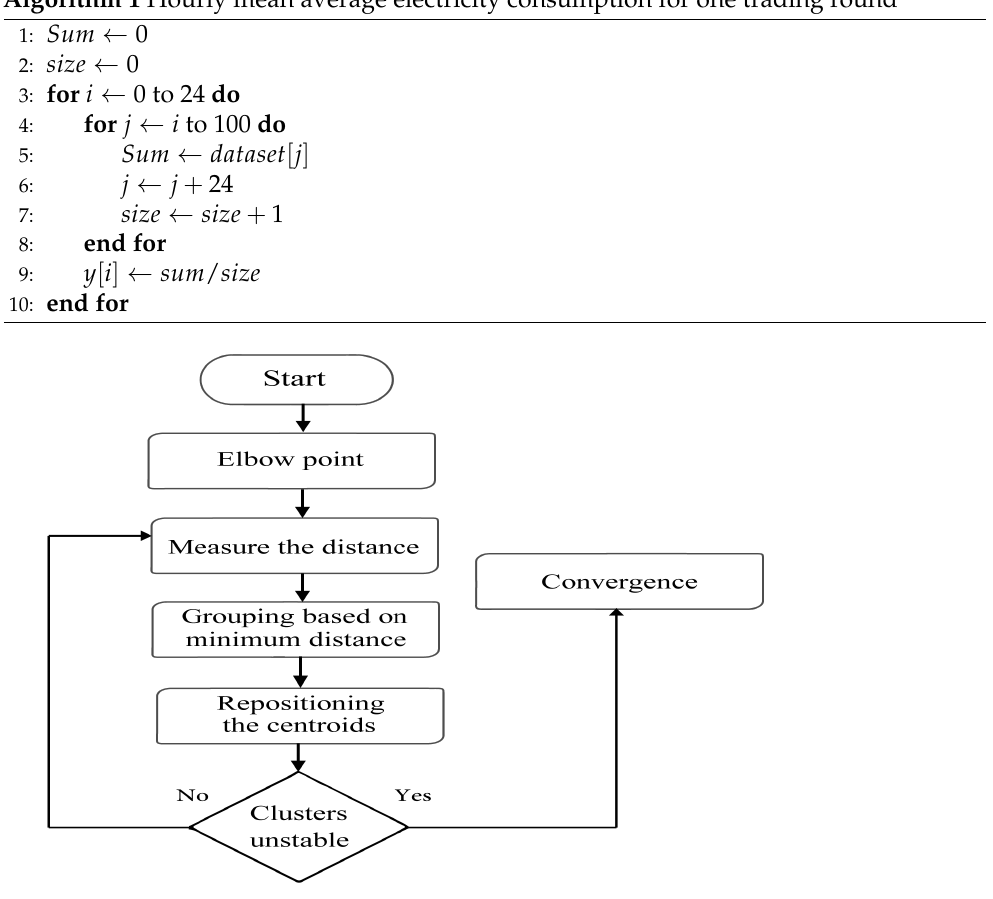
Figure 6. The K-mean algorithm flowchart.